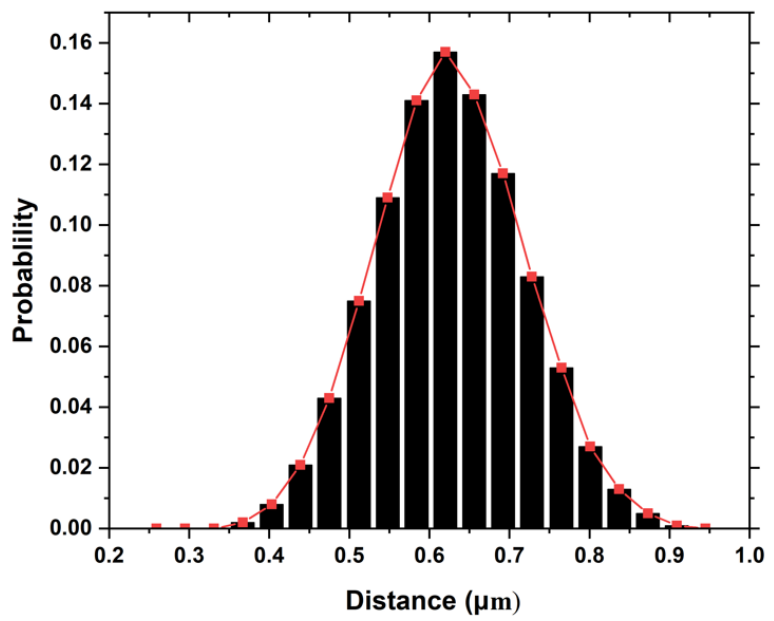
Figure 2. Normal distribution of the RVE for nearest neighbour distances of fibres in the composite with 3 wt.%.